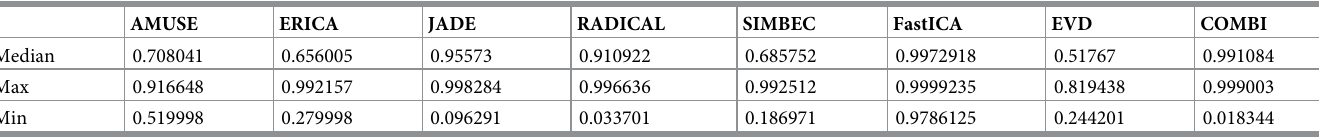
The results of FastICA (the most reliable results) presented higher SCC values than other algorithms.